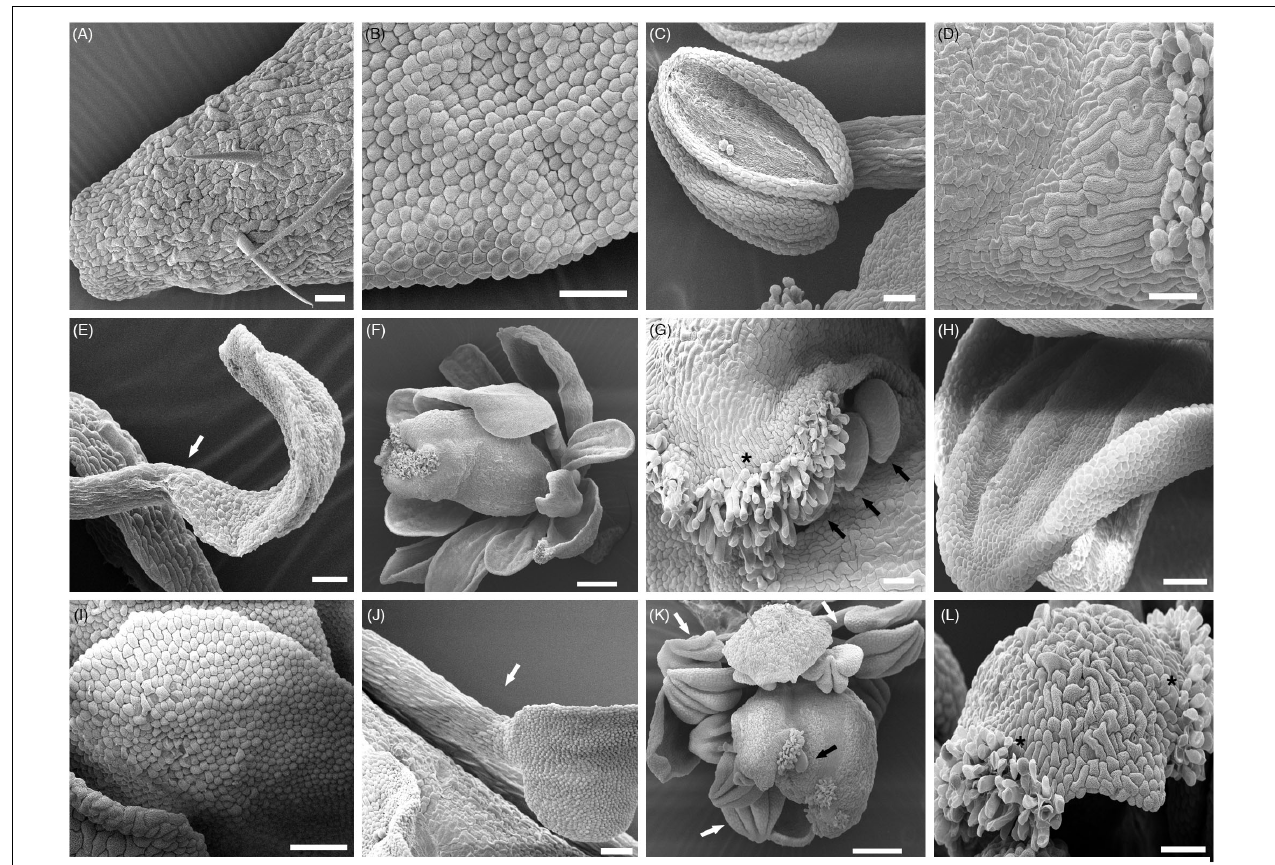
FIGURE 5 | SEM analyses of ectopic organs. (A) WT sepal; (B) WT petal; (C) WT stamen; (D) WT carpel; (E) Staminoid-petal in 35S:AtAG (WT background); (F) Meristem determinacy recovery in ag-3 35S:AtAG ; (G) Ectopic stigmas and ovules on sepals in ag-3 35S:AtAG ; (H) Mild petal-to-stamen conversion in ag-3 35S:AtAG , cells shape are more lobate than those in WT petals (B) resembling the shape of anther cells (C) ; the organ acquires the typical folds of the anther; (I) Mild petal-to-stamen conversion in ag-3 35S:OsMADS3 + S 109 , cells shape are more lobate than those in WT petals (B) resembling the shape of anther cells shown in (C) ; (J) Petal-to-stamen conversion in 35S:OsMADS3; (K) Staminoid-petals and meristem determinacy recovery in ag-3 35S:OsMADS3; an ectopic ovule is also visible; (L) Ectopic stigmas on sepals in ag-3 35S:OsMADS3. Ectopic stigmas on sepals (black asterisks), petal-to-stamen conversion (white arrows) and ectopic ovules (black arrows) are